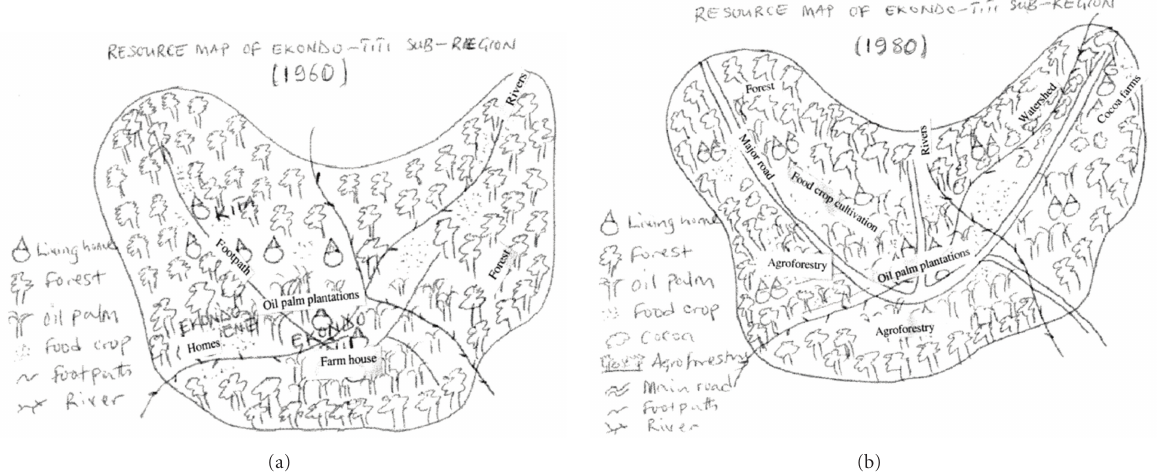
Figure 4: (a) Historical map of the past landscape showing the Ekondo-Titi region between 1940–1960. (b) Historical map of the past landscape showing the Ekondo-Titi region between 1960–1980. The maps (a) and (b) were drawn by members of the Ekondo-Titi traditional council with contributions from three elderly women in the village.